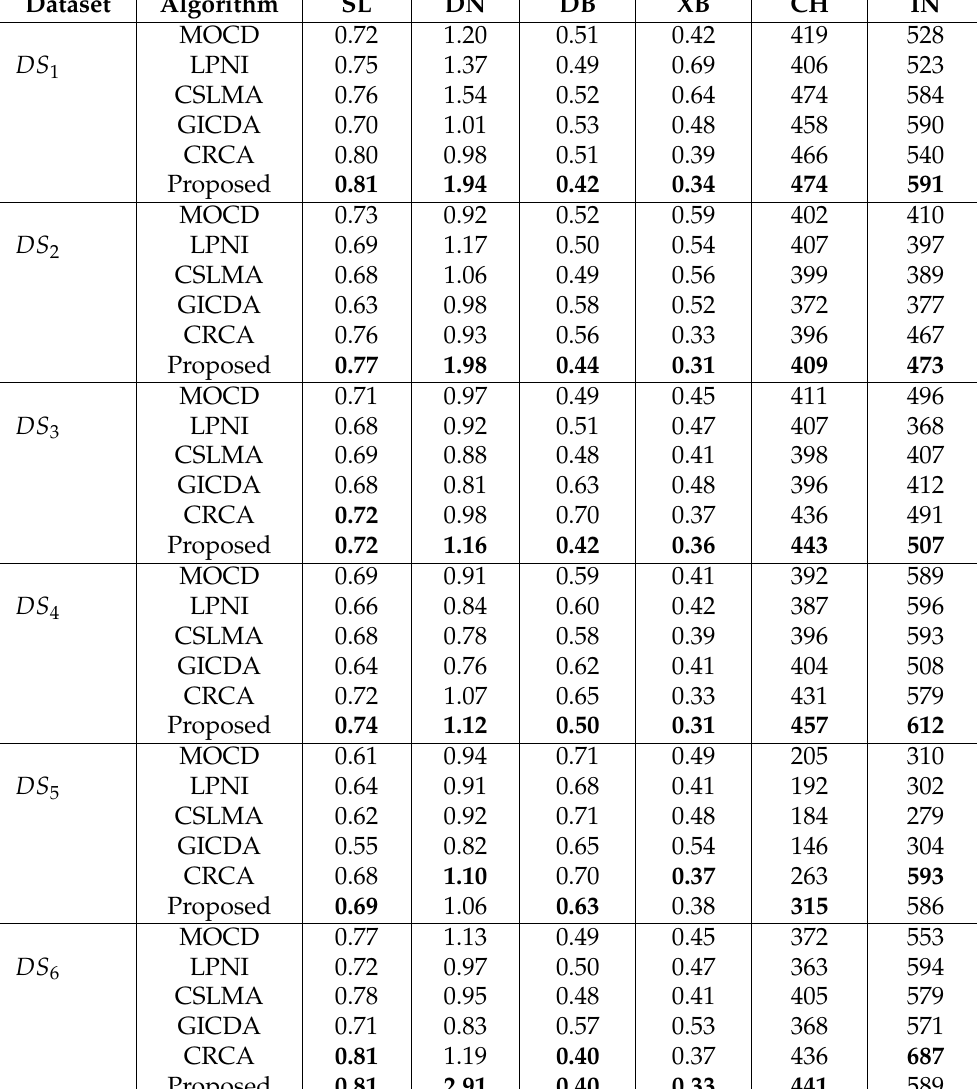
Table 2. Comparison of several clustering techniques using internal